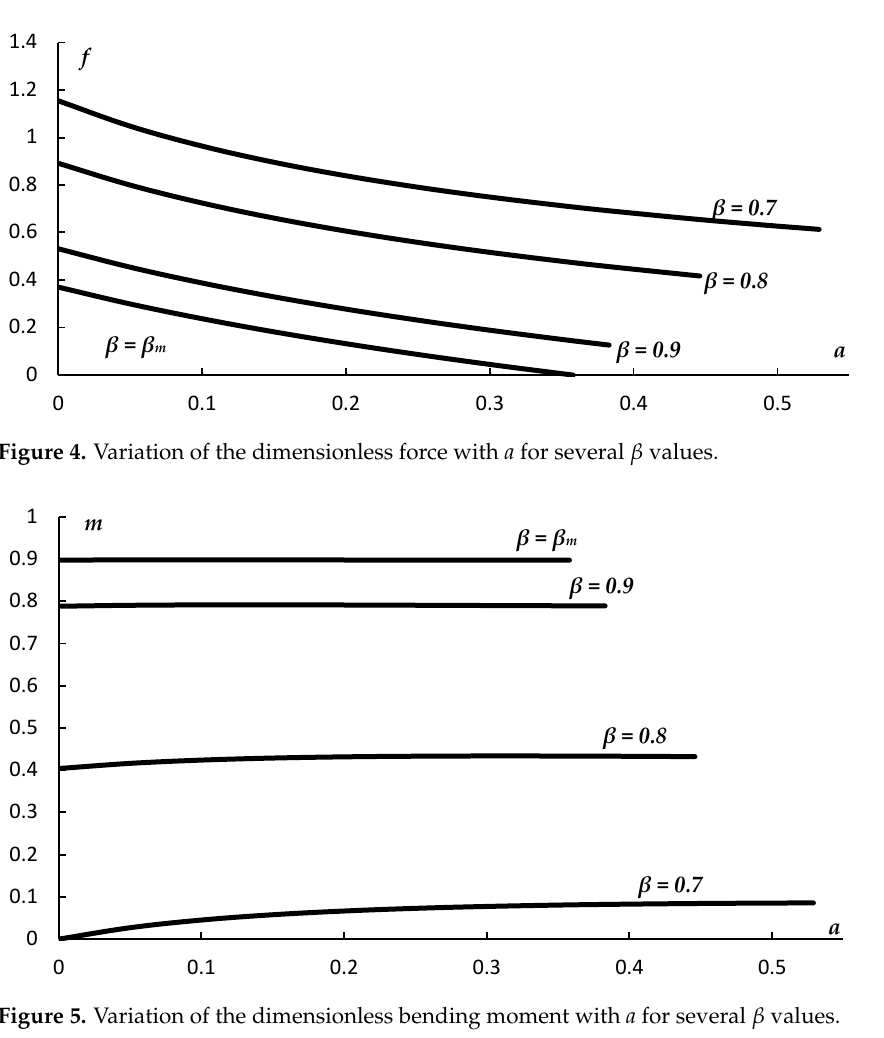
Figure 6. Loading paths in the ( f, m ) space for several β values.